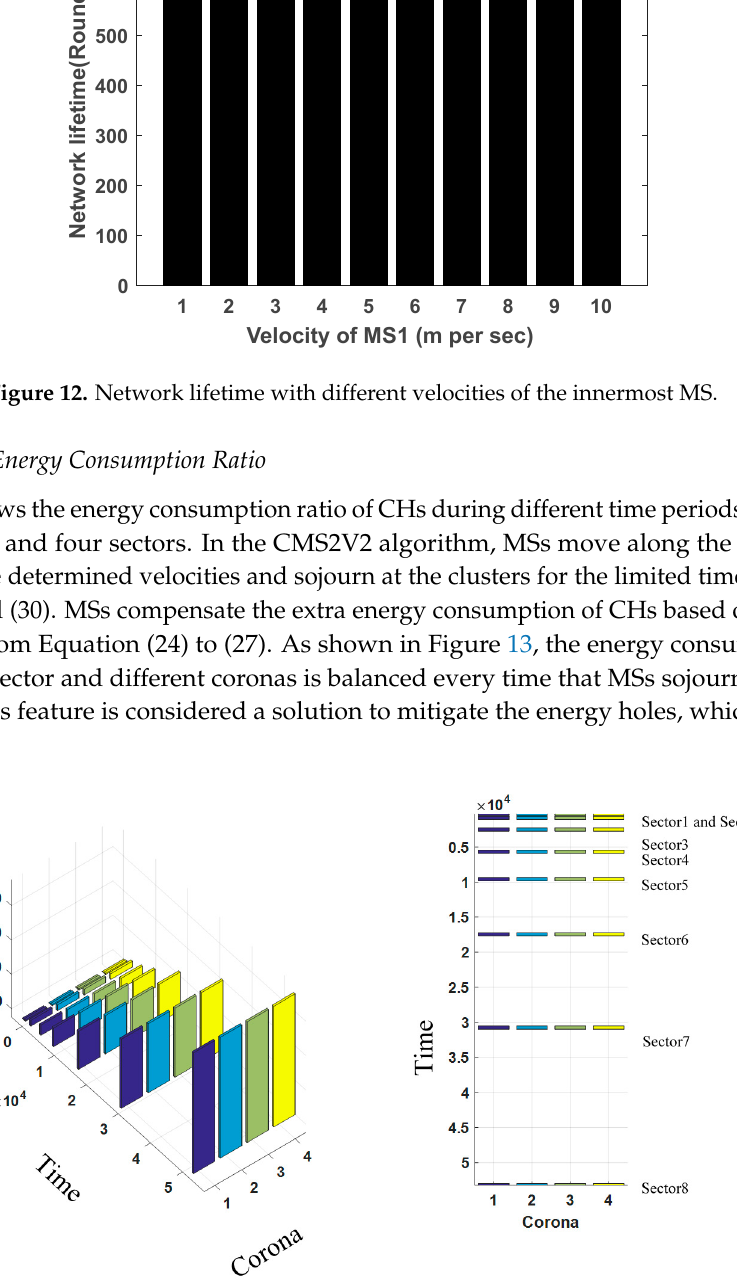
Figure 13. Energy consumption ratio of CHs.